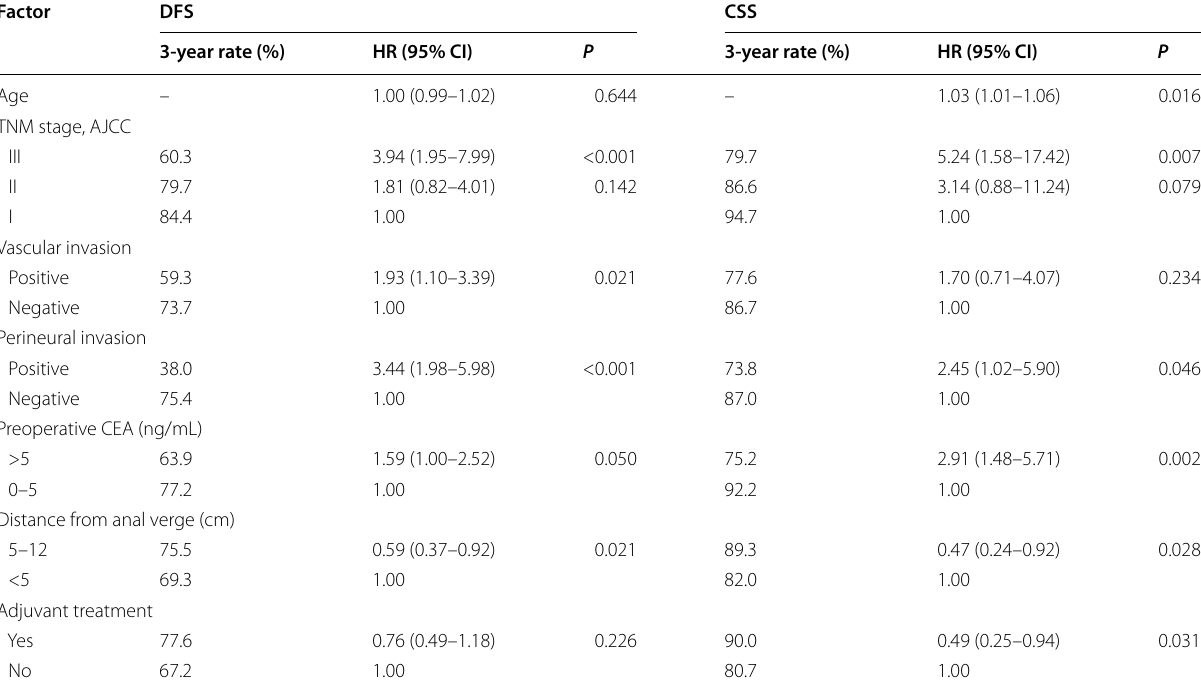
Table 2 Univariate analysis of prognostic factors for DFS and